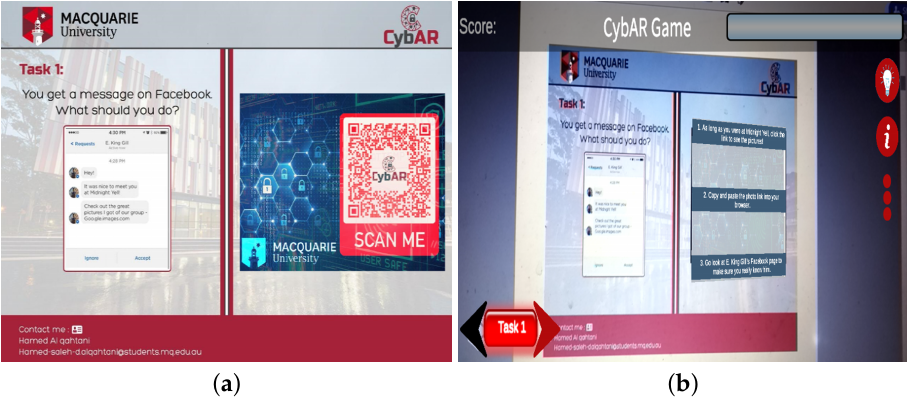
Figure 9. ( a ) Example of CybAR task 1. ( b ) Example of CybAR task